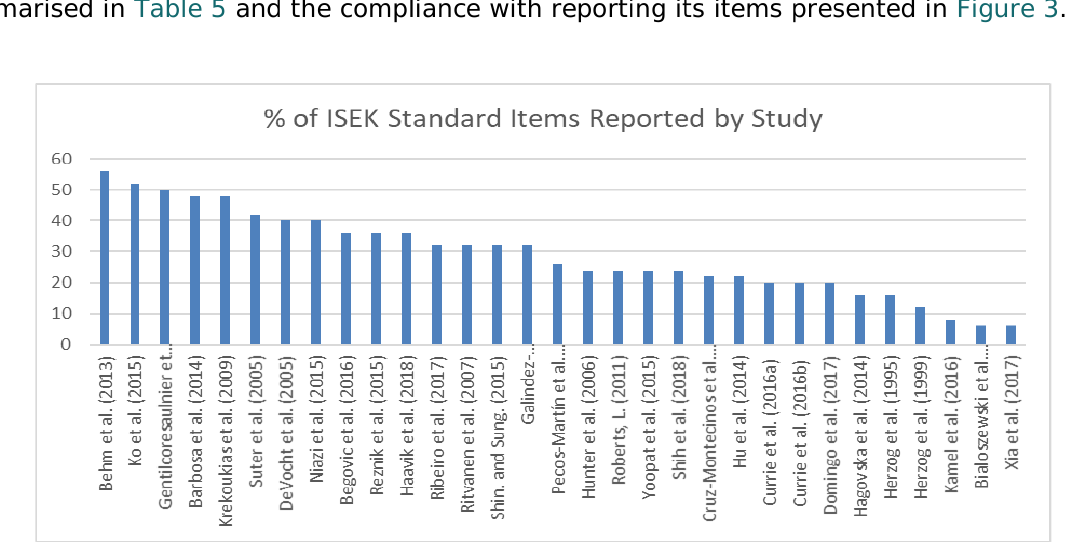
Figure 3. Percentage of ISEK standard criteria not reported by each